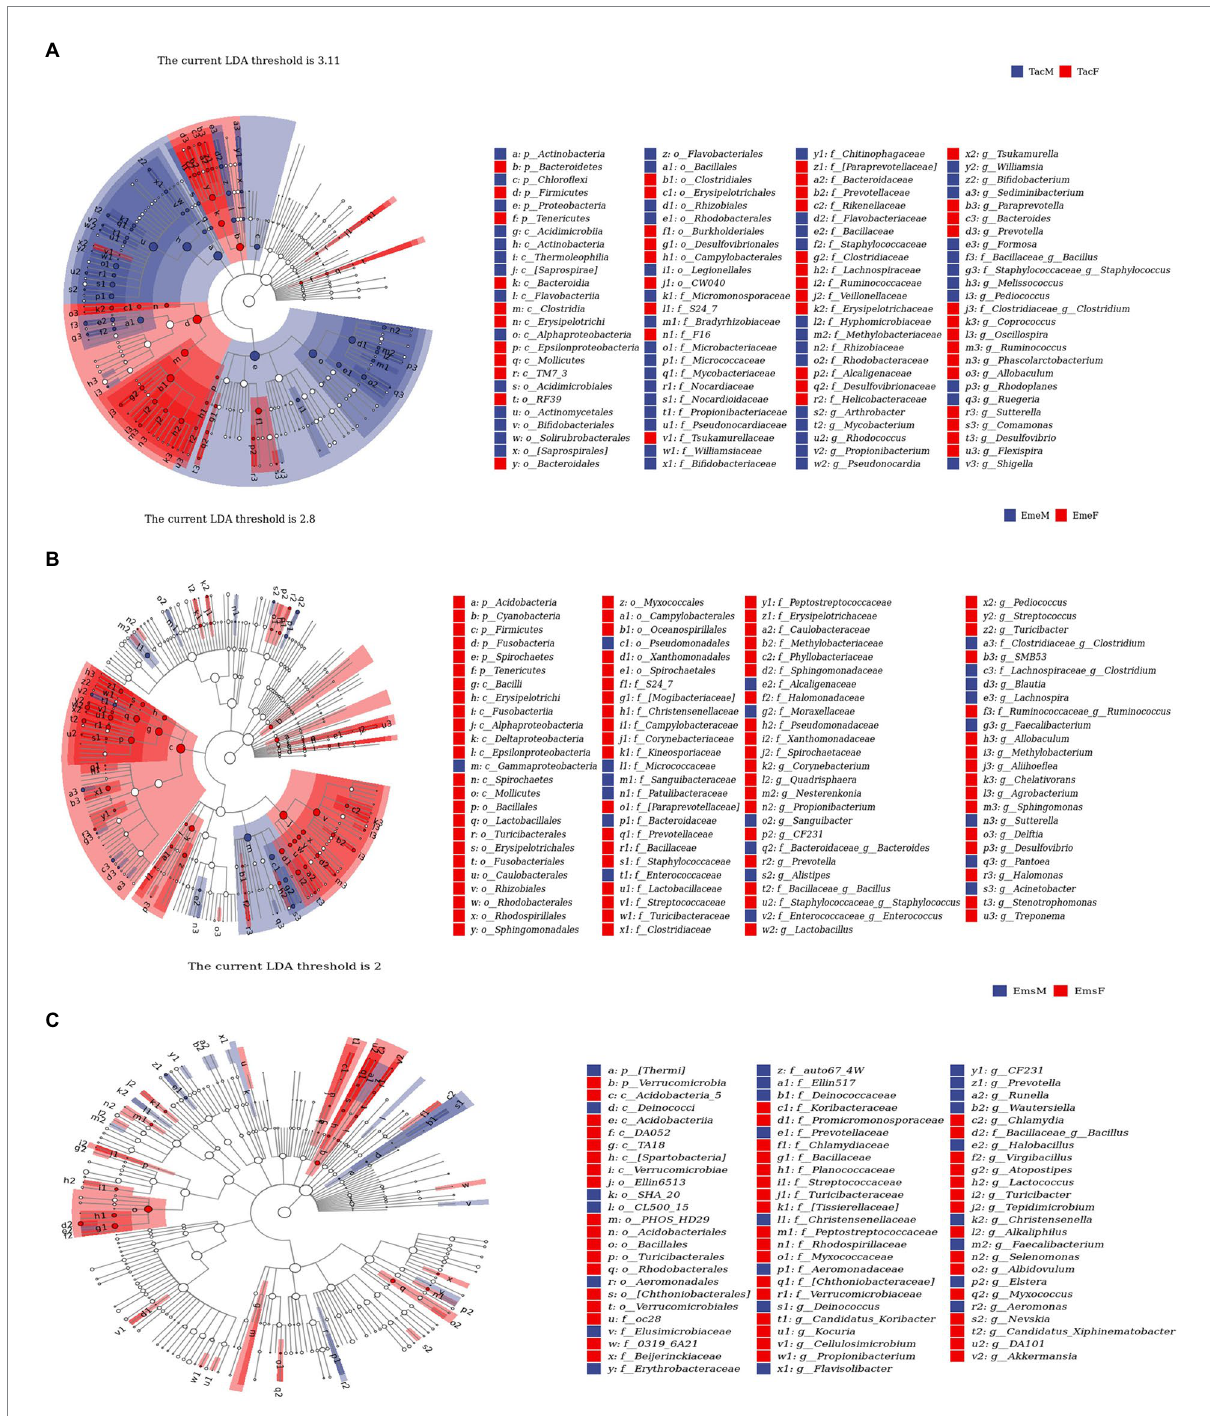
FIGURE 4 LEfSe species difference analysis-species taxonomy cladogram showing the taxonomic-level distribution of marker species between male and female individuals of (A) Tarsiger cyanurus , (B) Emberiza elegans , and (C) Emberiza spodocephala . The three migratory bird species have their own optimal thresholds (above the cladogram). Circles radiating from inside to outside represent the taxonomic hierarchy of the major taxonomic units from the phylum to genus in respective communities. p_:phylum, c_:order, o_:order, f_:family, g_:genus. The size of the nodes in the cladogram corresponds to the average relative abundance of ASV at the respective taxonomic level. The diameter of the node is proportional to the relative abundance. The hollow nodes represent species showing no significant differences, and the solid circles with different colors represent the relative abundances of significantly different species. Letters or letters/numbers at nodes in cladogram: labels for all different ASVs from the phylum to genus. Letter–number combinations were assigned per Figure part and do therefore not correspond to each other between the different Figure parts (A–C) . Species with taxonomic names in brackets have no clear taxonomic understanding yet but exist in the database, that is, suspected taxonomy of the species (further validation is required). We kept the original Greengenes assignments, even if genera were assigned to wrong classes. We ensured that this did not change our results or conclusions. The abbreviations in this figure are expanded in the legend of Figure